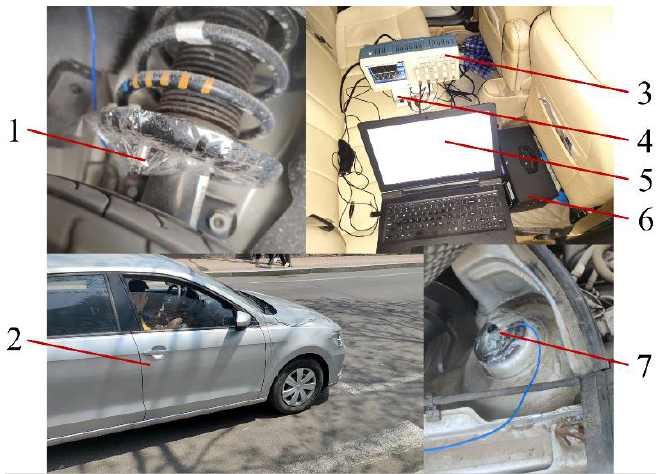
Figure 9. Test vehicle and test equipment diagram. 1/7. Acceleration sensor 2. Test car 3. Digital oscilloscope 4. Data acquisition card 5. Upper computer 6. External power supply.